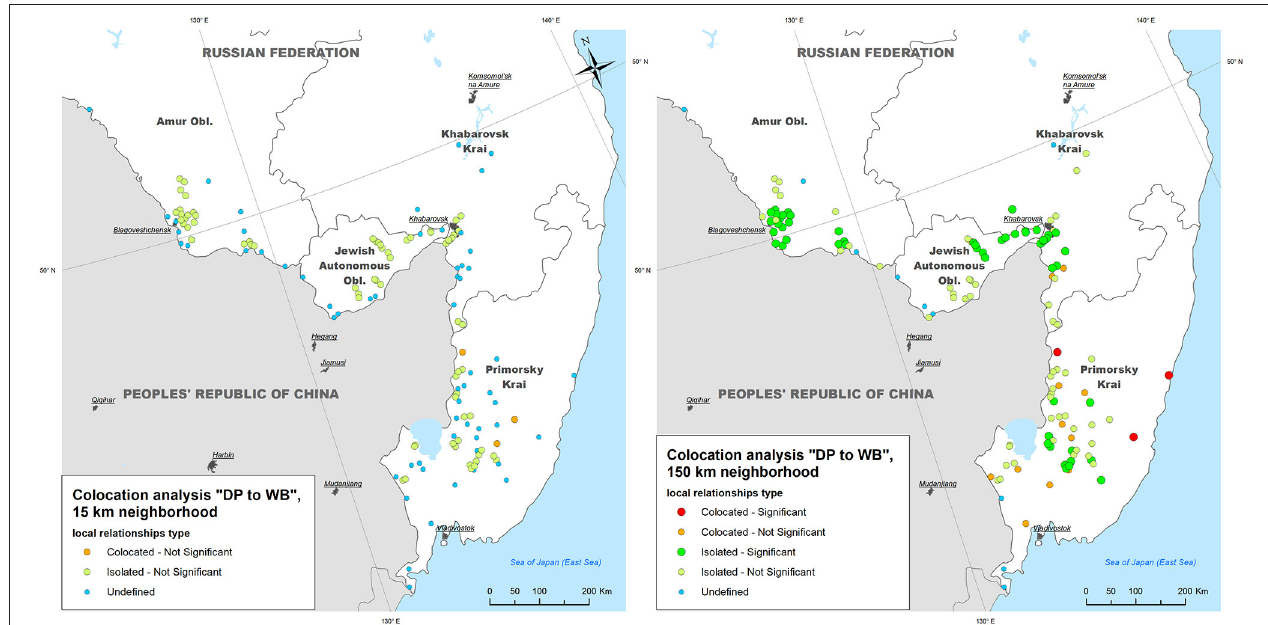
FIGURE 4 | The results of local colocation analysis of ASF outbreaks in domestic pigs (DP) and wild boar (WB). (Left) With 15km as a neighboring distance; (Right) with 150km as neighboring distance.